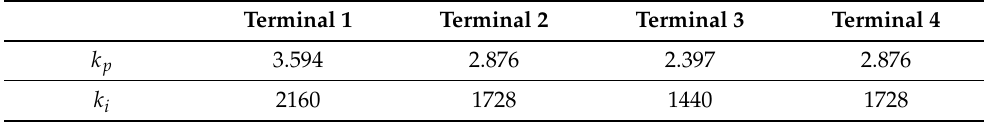
Table 2. Parameters of the controllers R i ( s ) for each